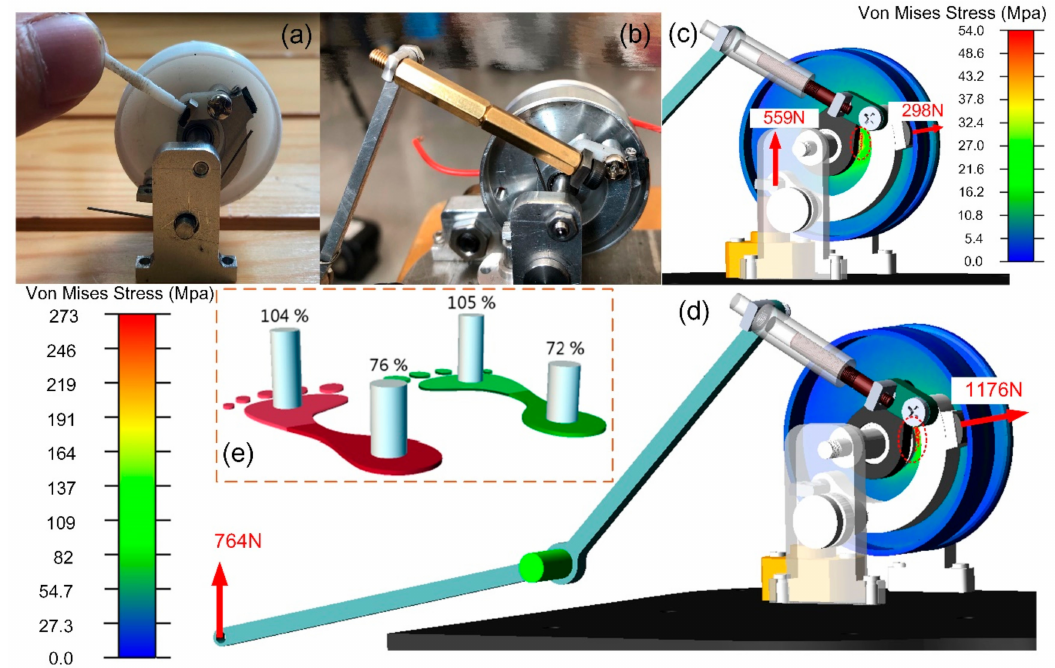
Figure 9. The prototype of the proposed sensor-control integrated clutch. ( a ) Original prototype with 3D printed pulley, felly, and connecting rod; ( b ) Second prototype with all components made of Al-alloy. ( c ) Finite element model when the bottom gripper su ff ers from the ground reaction force (GRF); ( d ) The finite element model when the bottom gripper su ff ers from the GRF; ( e ) The distribution of the body weight at the fore and rear